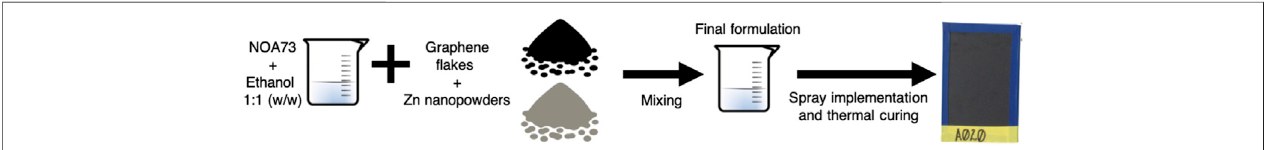
FIGURE 5 | Schematic representation of the fabrication of the doped anti-corrosive coating.